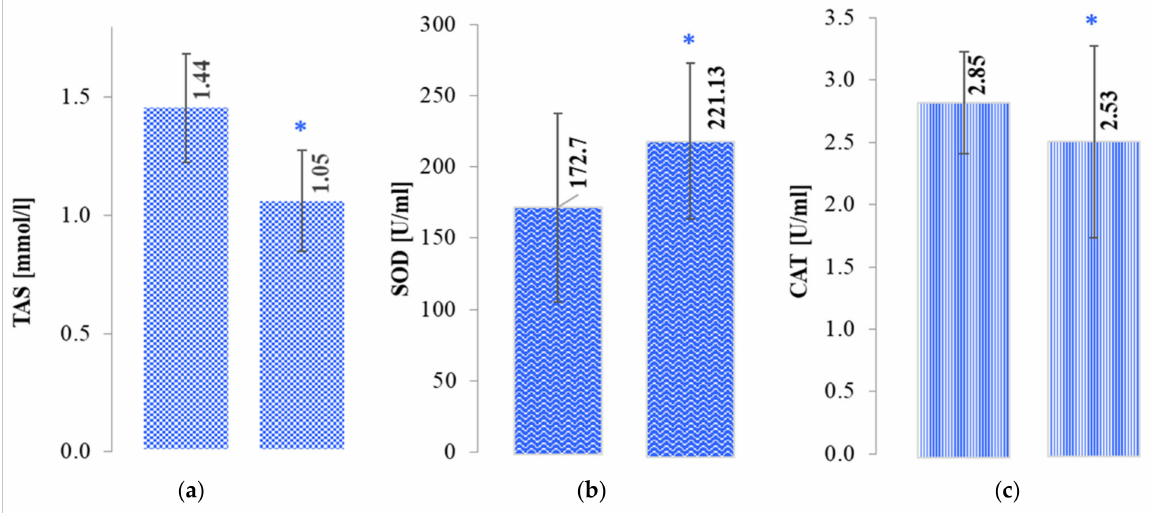
Figure 11. The activity of ( a ) TAS, ( b ) SOD and ( c ) CAT in the control group and the post-chemotherapy group